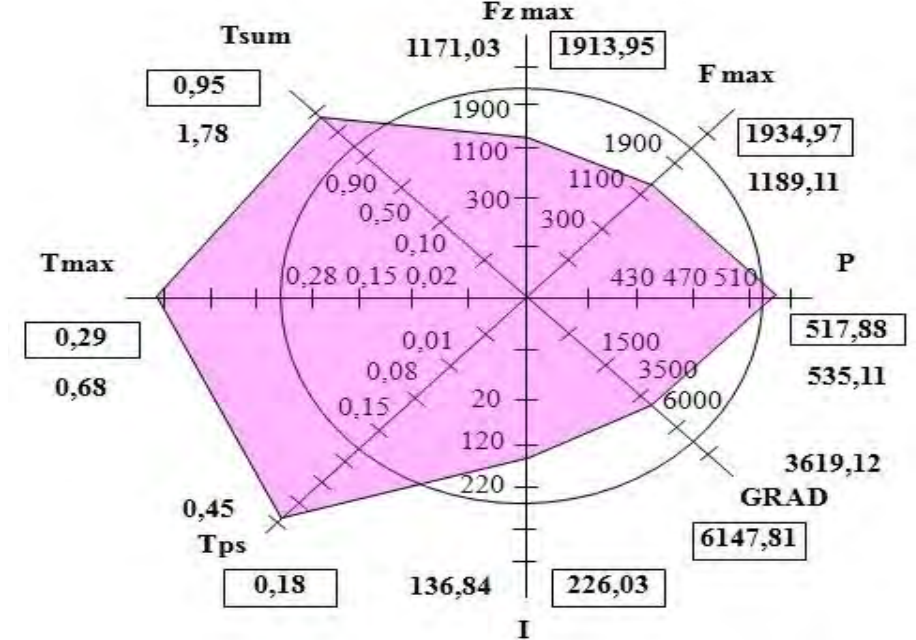
Fig.1. Graphic-analytical model of bio-dynamic structure of high jump from the spot, fulfilled by